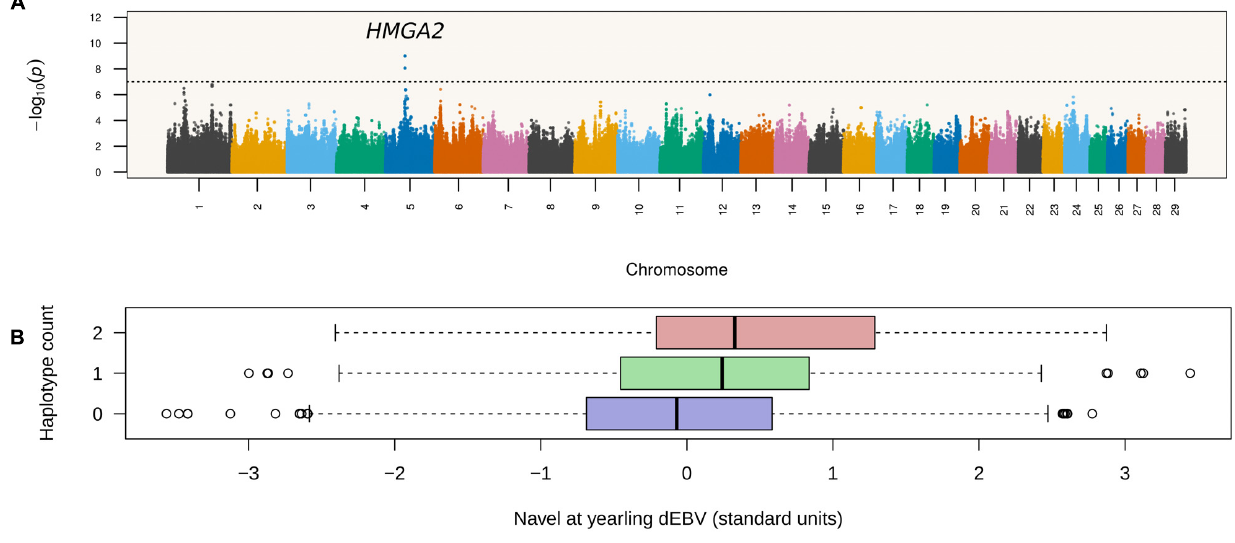
FIGURE 1 | Haplotype-based GWAS maps navel length at yearling associations to a locus containing HMGA2 . (A) Each point in the Manhattan plot corresponds to a six-marker long haplotype. The dashed horizontal line corresponds to the Bonferroni threshold ( p < 2.44 × 10 − 8 ). (B) Distributions of deregressed EBVs according to number of copies of the leading haplotype. The HMGA2 locus accounted for 2.04% of the variance in deregressed EBVs. TABLE 1 | Effects of the HMGA2 -CNVR tag haplotype on deregressed estimated breeding values of nine traits in Nellore cattle. Trait Sample size Unweighted regression a Weighted regression b Coefficient p -value